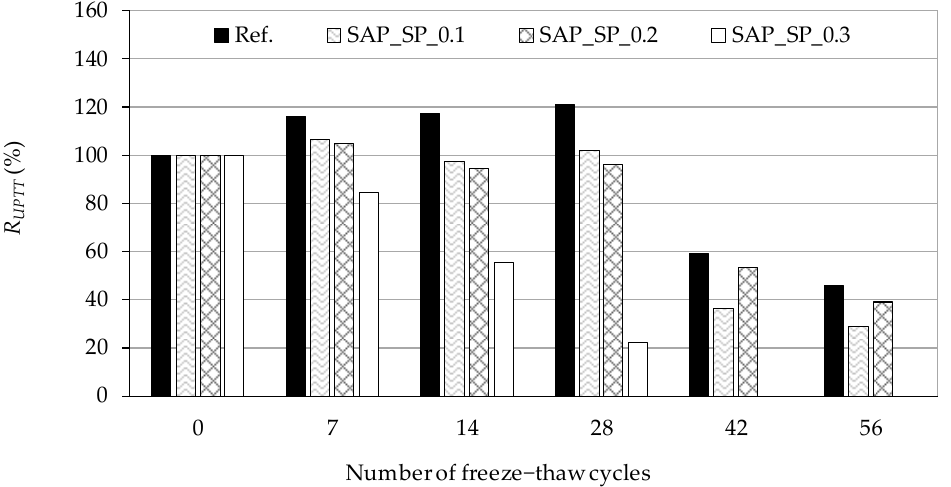
Figure 7. Relative dynamic modulus ( R UPTT ) of samples according to the number of freeze − thaw cycles .